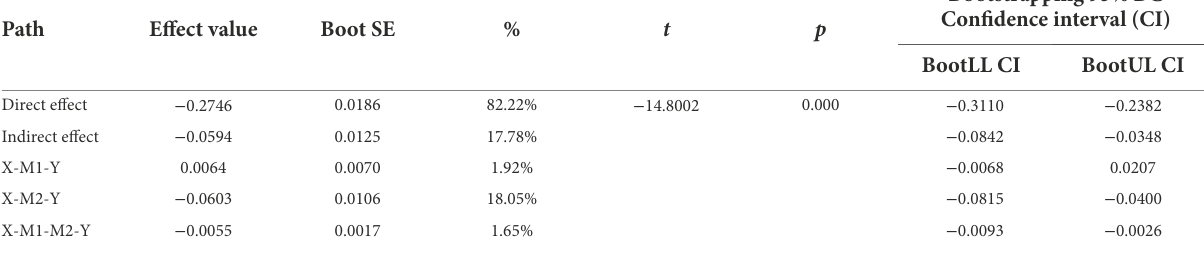
TABLE 3 Mediating role analysis of depression of physicians.